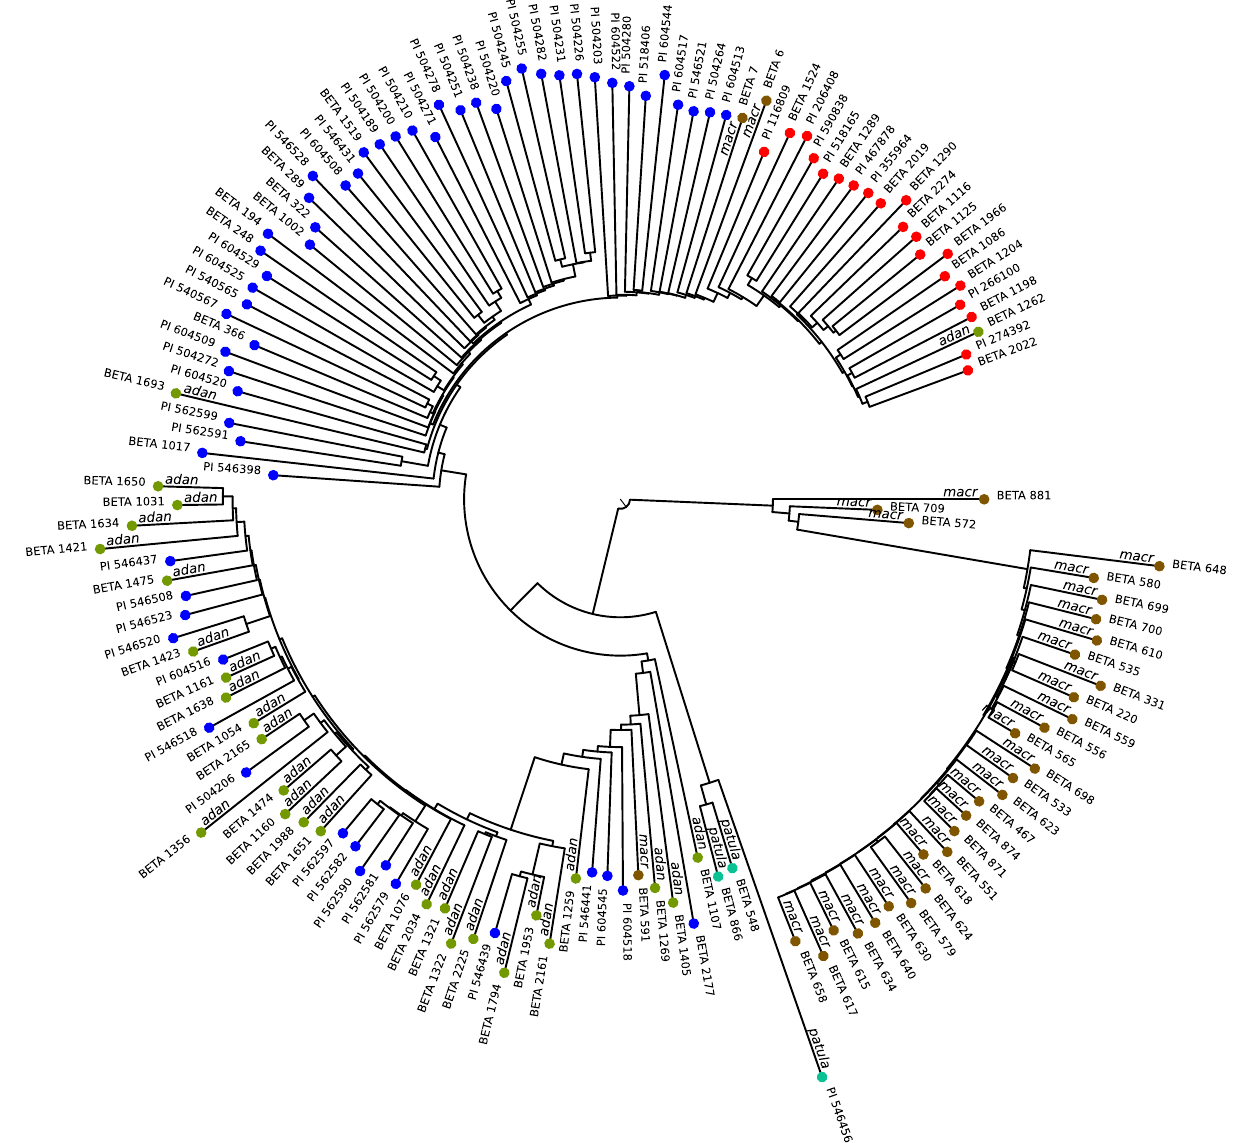
Fig. 6 Phylogenetic relation of wild beet accessions based on Mash distances. A set of 60 sea beets from the Mediterranean area and 20 sugar beets (randomly selected) was analysed together with accessions of three further wild beet species. Node colors indicate taxonomic af fi liation according to passport data. Blue: B. v. maritima , red: B. v. vulgaris , olive: Beta vulgaris ssp. adanensis , brown: Beta macrocarpa , turquoise: Beta patula . Source data are provided as a Source Data fi